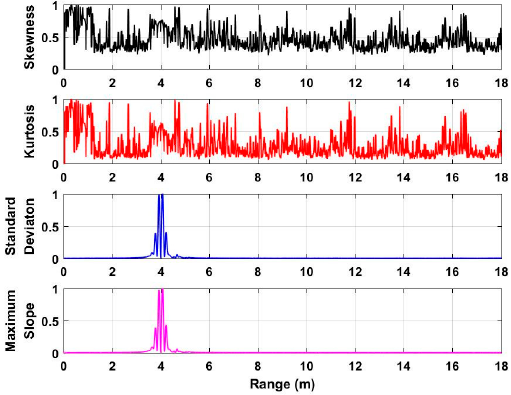
Figure 6. The analyzed characteristics based on the acquired data at a distance of 4 m.